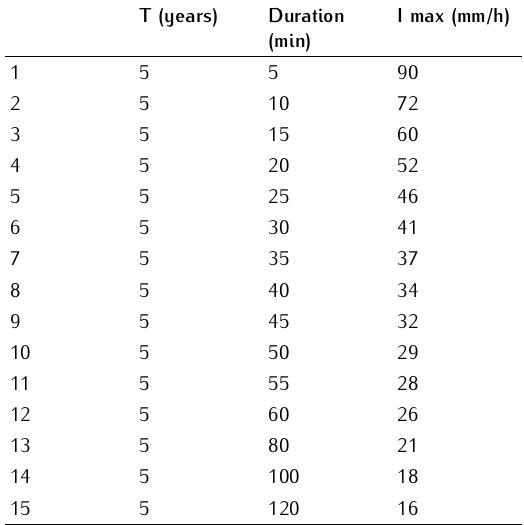
Table 2. Return period, duration and intensity of rain. Source: Sequeira,